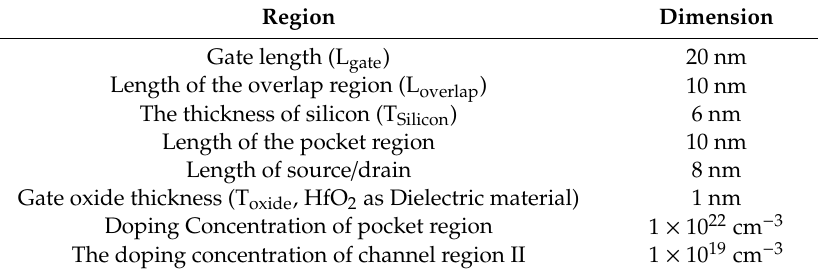
Table 1. Dimensions of the AJ DG MOSFET with n + pocket